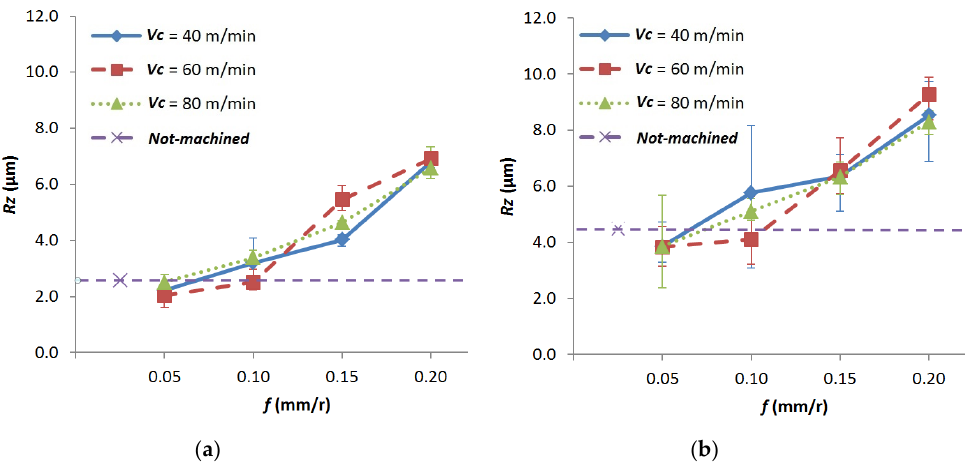
Figure 5. Maximum height of the profile ( Rz ) as a function of feed ( f ) and cutting speed ( v c ), ( a ) before and ( b ) after a corrosion process.